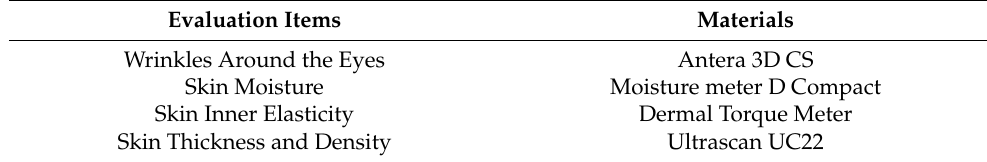
Table 1. Materials employed in the study.